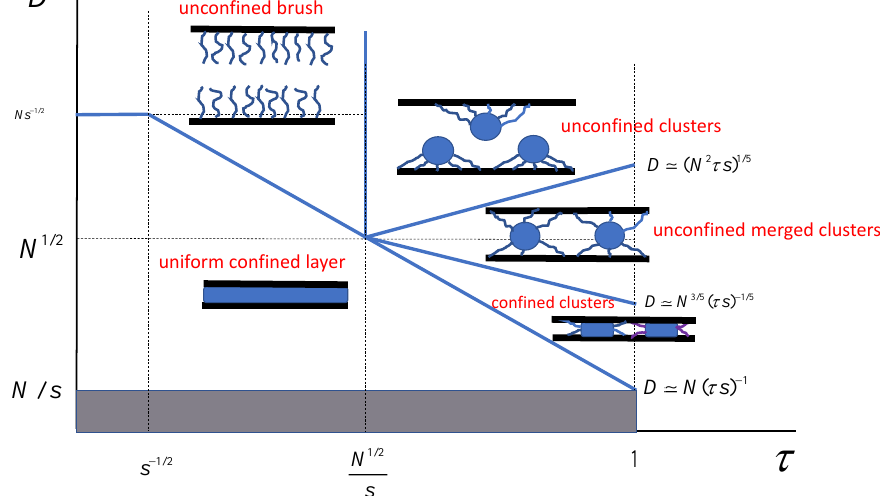
Figure 12. Diagram of states of the brush compressed in a planar slit-like pore under poor solvent conditions in the pore width D , - solvent strength, and τ